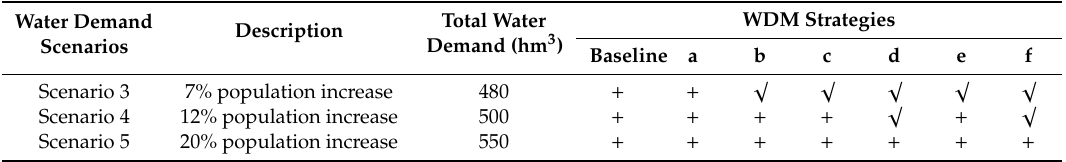
Table 6. Summary of results of water demand management strategies